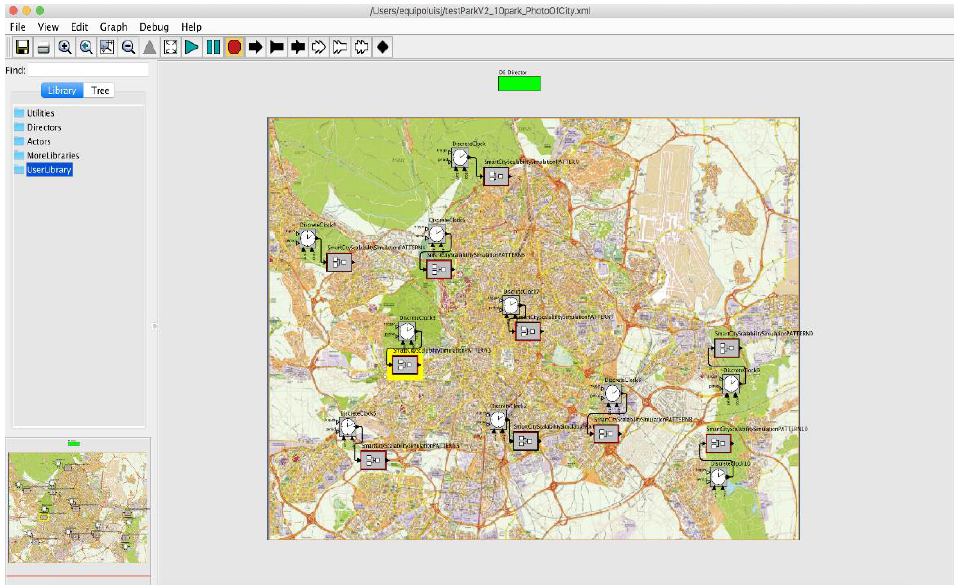
Figure 15. Location of the parks in a city.